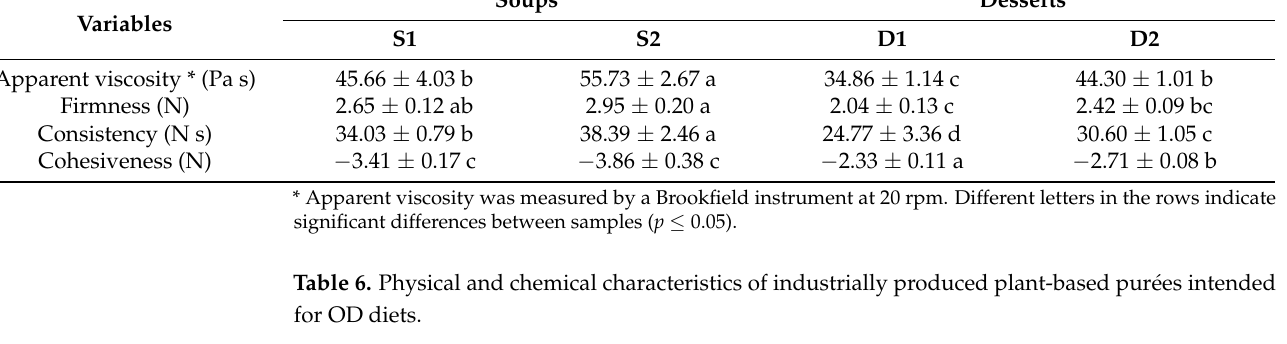
Table 5. Rheological properties of industrially produced plant-based pur é es intended for OD patients. Soups Variables